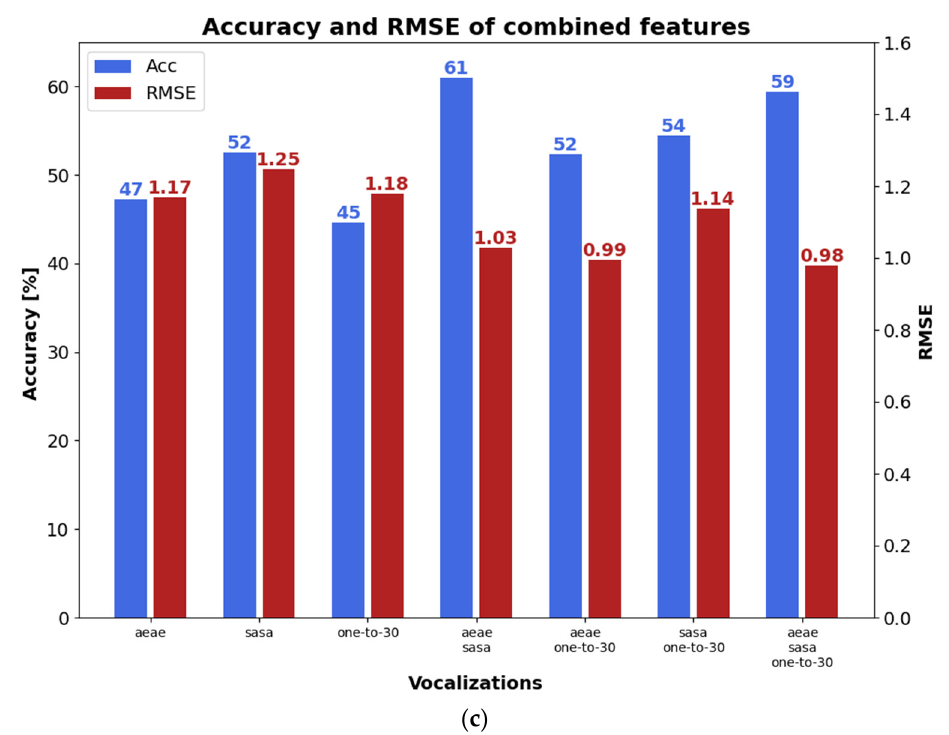
Figure 5. Accuracy and RMSE with single and combined classifiers: ( a ) time ‐ independent features; ( b ) time ‐ dependent features; and, ( c ) combined time ‐ independent and time ‐ dependent features.